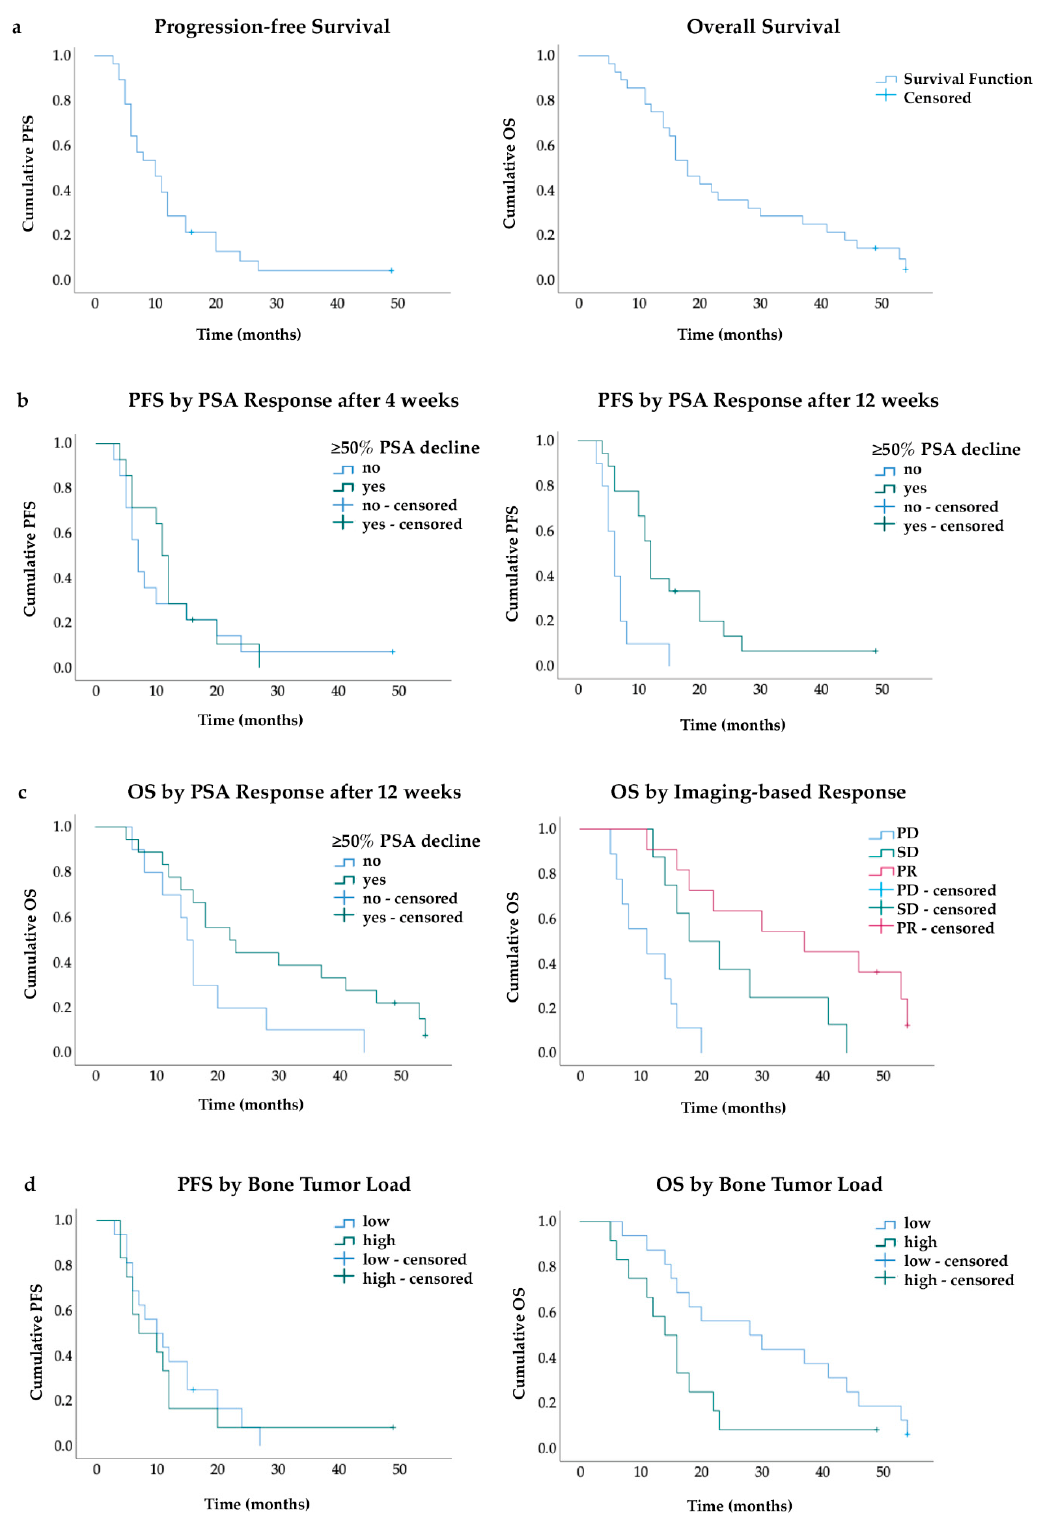
Figure 2. Kaplan–Meier curves ( a ) OS and PFS in whole cohort ( b ) PFS by PSA response after 4 and 12 weeks ( c ) OS by PSA and imaging-based response ( d ) PFS and OS by bone tumor load; PFS: progression-free survival, OS: overall survival, PR: partial response, SD: stable disease, PD: progressive